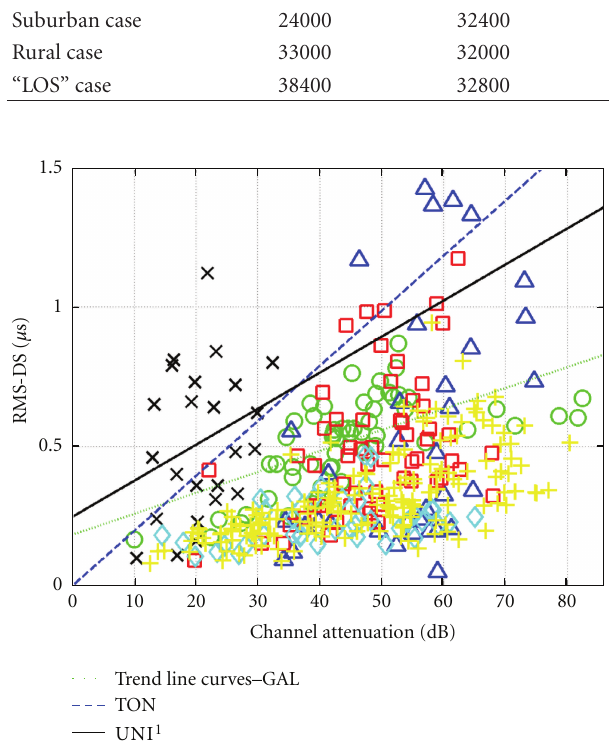
Figure 6: Scatter plot of RMS-DS versus average end-to-end channel attenuation for simulated channels—overhead HV/BPL networks for the propagation of DM 4 and coupling scheme WtG 1 — ( × ), measured channels—underground MV/BPL power network ( (cid:6) ), test MV/BPL power network ( (cid:7) ), in-home LV/BPL suburban networks ( (cid:2) ), in-home LV/BPL urban networks ( ♦ ), and indoor LV/BPL power networks (+)—, and trend line curves—GAL ( ··· ), TON ( - - ), and UNI 1 ( — )